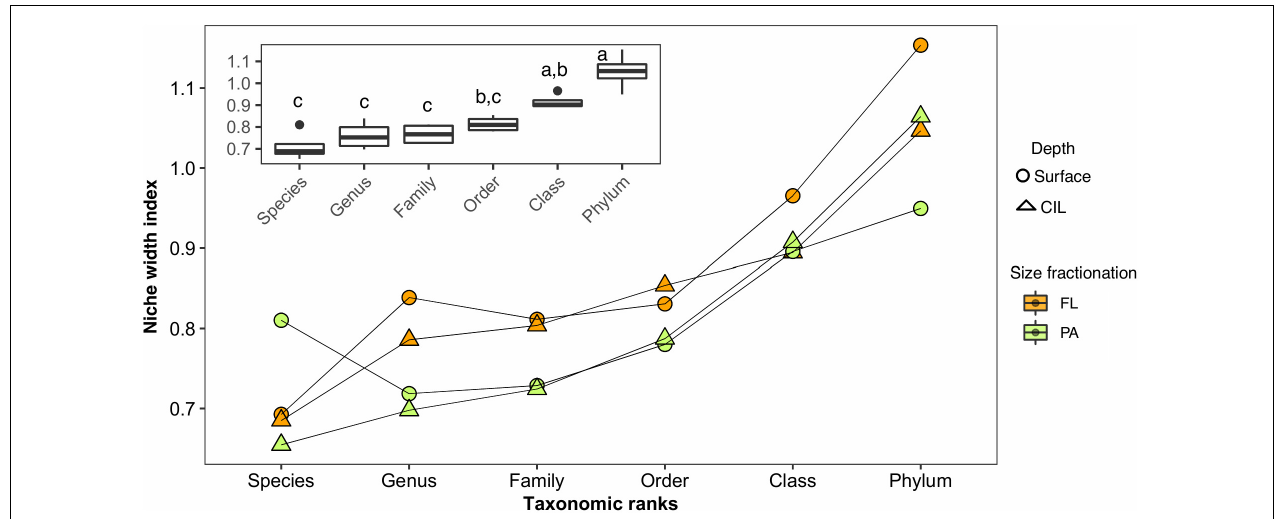
FIGURE 6 | Niche width index (derived from the slope of the logarithm of the abundance values plotted against the number of occupied sites) of the subcommunities along hierarchical taxonomic ranks and the corresponding median rate at each taxonomic rank (inset), without evolutionary information on the bacteria. The different colors indicate the different lifestyles, and the different symbols indicate the different water depths. An analysis of variance (ANOVA) was used to test for significant differences ( P < 0.05) in the niche width index as a function of the taxonomic level. The subcommunities function as replicates for the ANOVA; thus, the values obtained from the subcommunities were used to calculate the variance of these replicates. Tukey’s post hoc test was used to determine the taxonomic level at which the differences occurred. The corresponding homogeneous groups are indicated by a, b and c. The values of the slopes of the AORs of the individual communities are given in Supplementary Table 7A